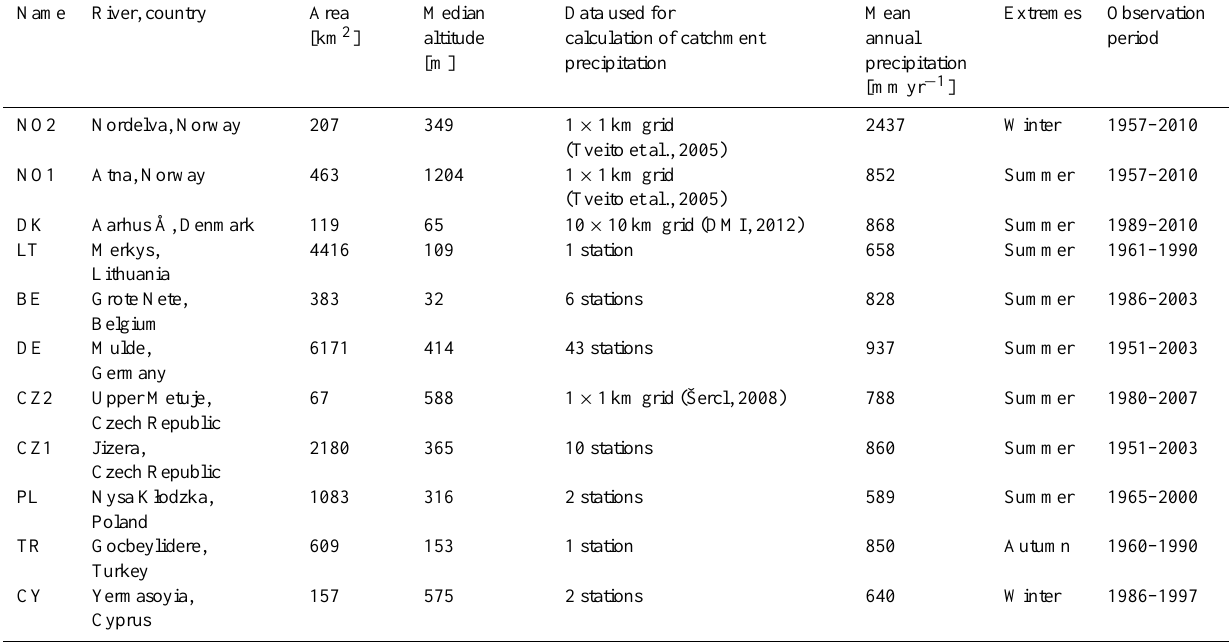
Table 1. Summary of the main characteristics of the catchments. The column with the label extremes indicates the season where most precipitation extremes occurred. The catchments are sorted from north to south, with the most northern catchment in the top